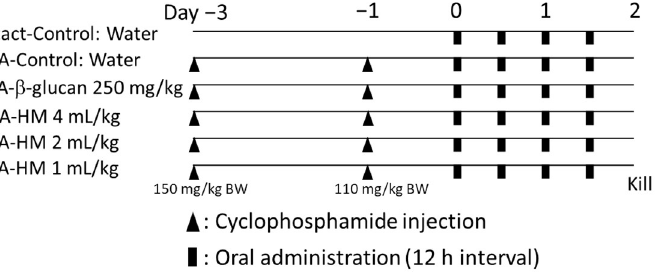
Figure 1. Study experimental design. In this study, we examined the effects of treatments on six groups comprising 10 mice each. In the five groups initially treated with CPA, mice were intraperitoneally administered 150 and 110 mg/kg of body weight CPA on days 3 and 1 day prior to oral treatment. The experimental compounds were orally administered four times at 12-h intervals, commencing on the day following the second CPA administration. Control mice without initial CPA treatment were intraperitoneally administered an identical volume of sterile saline. CPA: Cyclophosphamide, HM: Hemomine (60% LJG305).